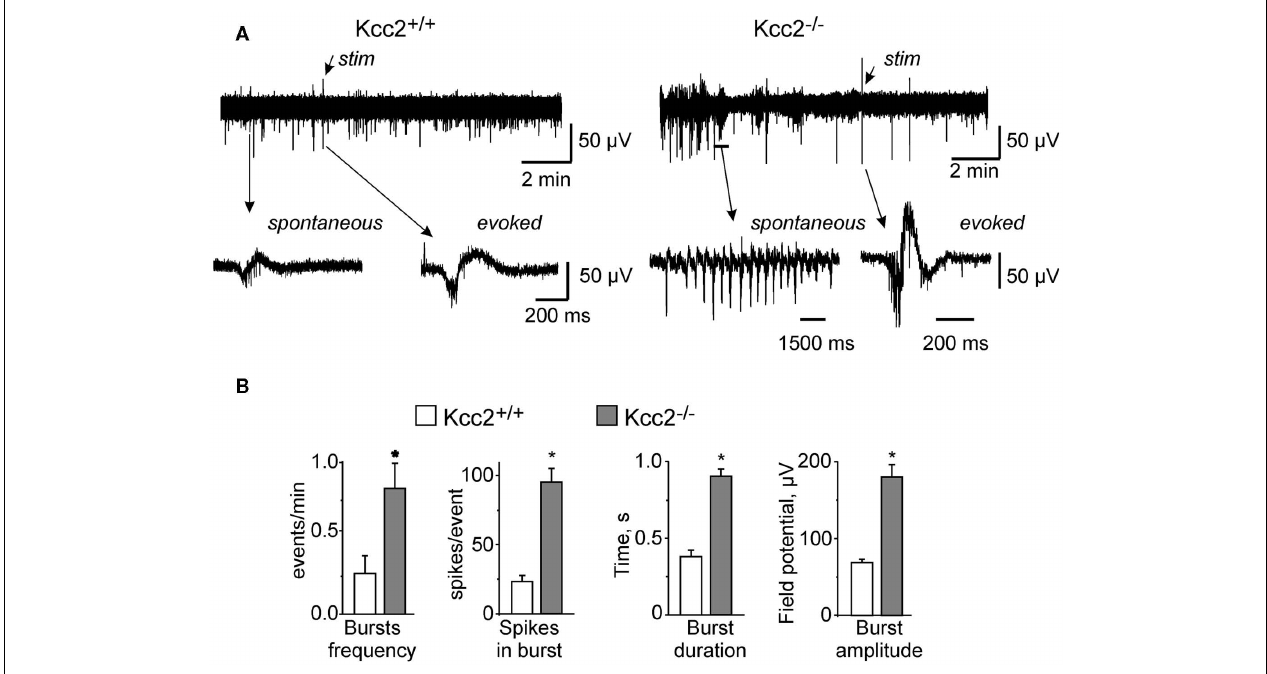
FIGURE 1 | Ongoing neuronal network activities in hippocampi (E18.5) from wild-type ( Kcc2 + / + ) and Kcc2 knock-out (Kcc2 − / − ) mice. (A) Examples of field potential recordings from intact hippocampi of Kcc2 + / + (left)